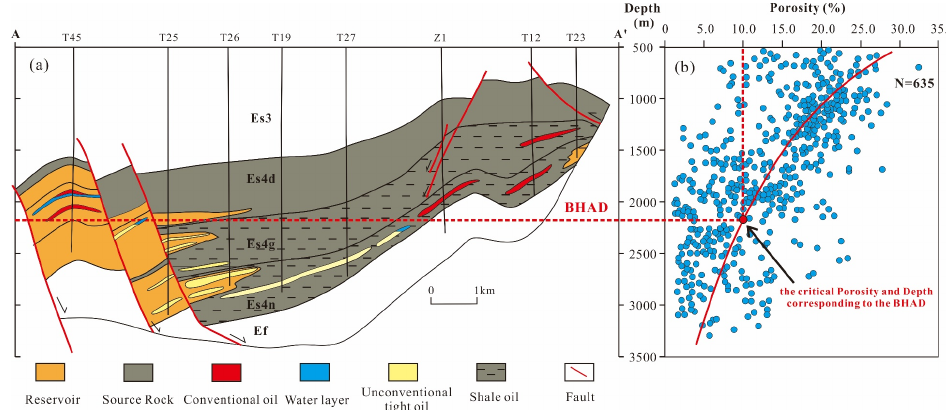
Figure 17. Determination of the BHAD in the Niuxintuo area. ( a ) Hydrocarbon reservoir profile. ( b ) Variation in porosity with burial depth.